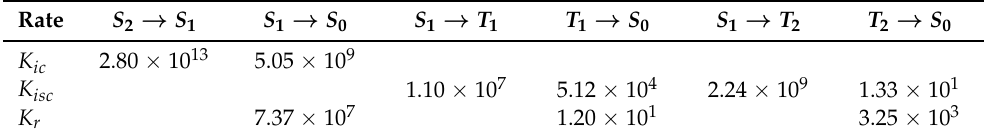
Table 3. Radiative and non-radiative rate constants (in s − 1 ) of S-BF2.